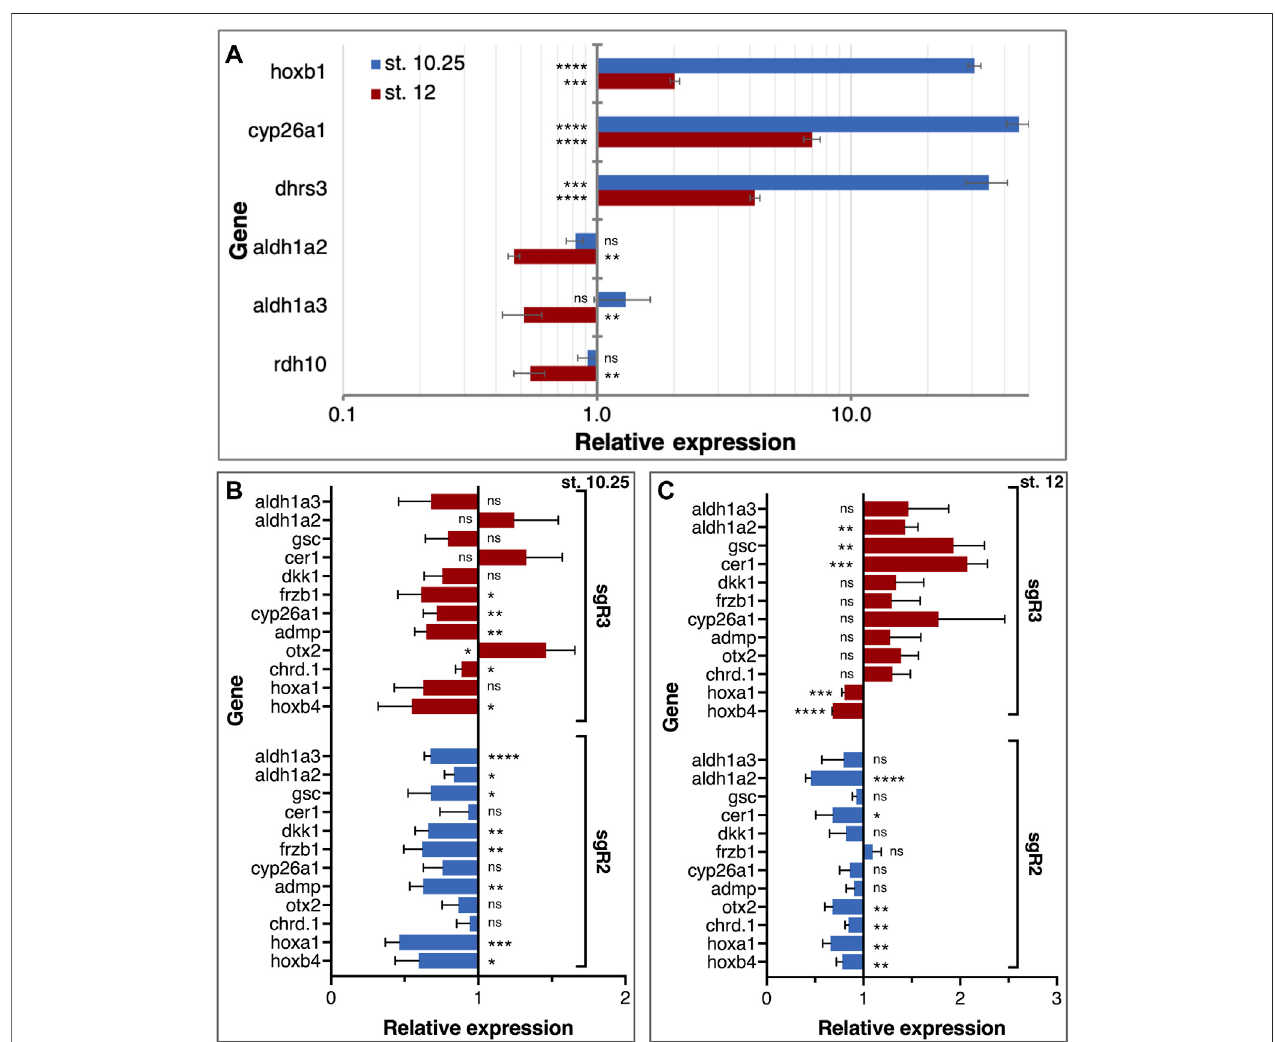
FIGURE8| RAautoregulationandcontrolofLEM/PCMgeneexpression. (A) EmbryosweretreatedwithRA(100 nM)duringlateblastulastagesandRNAsamples werecollectedduringearly(st.10.25)andlate(st.12)gastrulastages.TheeffectofthemanipulationonRAnetworkgeneexpression( dhrs3 , cyp26a1 , aldh1a2 , aldh1a3 , and rdh10 ) was determined by qPCR. The expression of hoxb1 was studied to monitor the changes in RA level. Samples were normalized to control expression level at each stage. (B,C) The expression of organizer genes linked to head formation ( gsc , cer1 , dkk1 , frzb1 , admp , otx2 , and chrd.1 ) was analyzed in aldh1a2 and aldh1a3 CRISPants. The RA-regulated genes, cyp26a1 , hoxa1 , hoxb4 , aldh1a2 , and aldh1a3 , were studied in parallel. The gene expression analysis was performed at st.10.25 (B) andst.12 (C) .Relativeexpressionwasnormalizedtocontrolexpressionlevelsateachstage.*, p < 0.05;**, p < 0.01;***, p < 0.001;****, p < 0.0001;ns,not signi fi